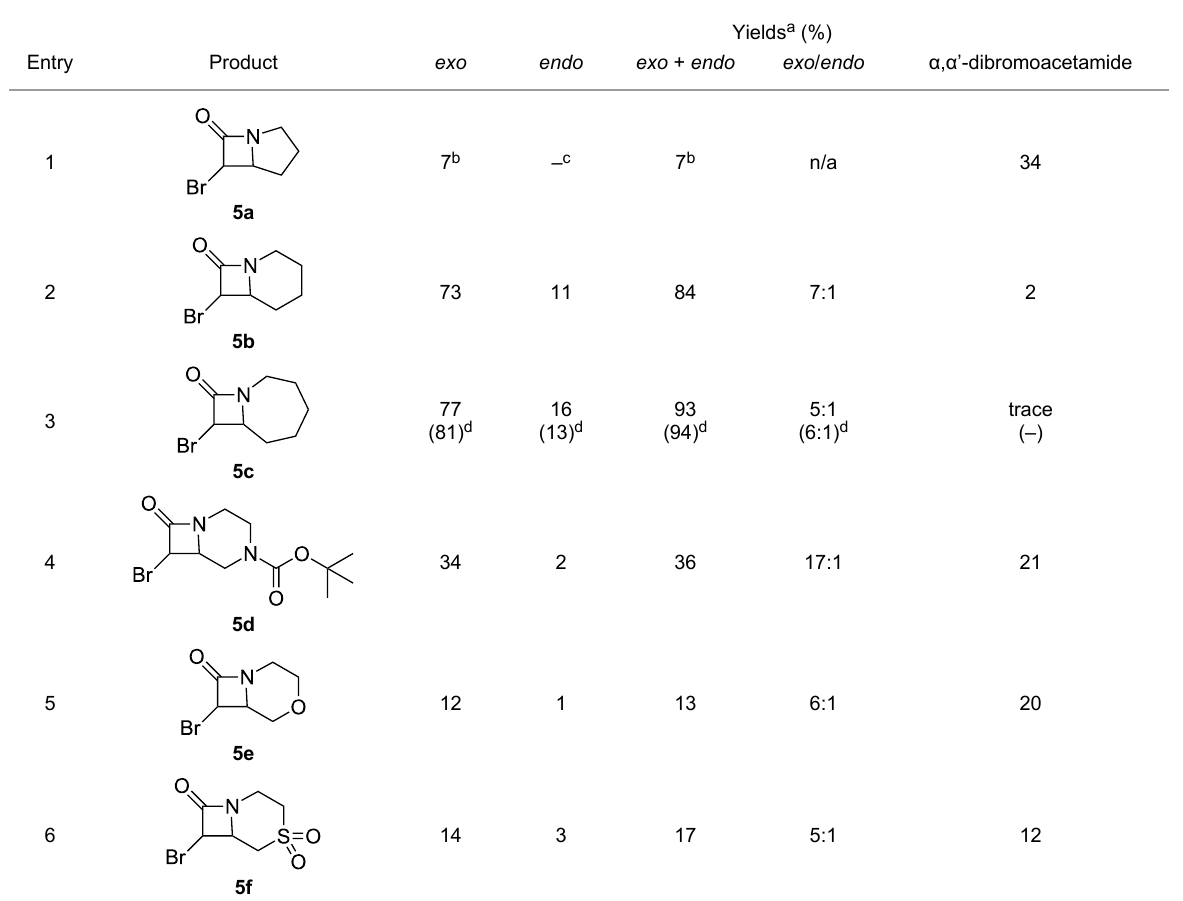
Table 1: Yields a of β -lactams 5a – f obtained by thermolysis of α -bromodiazoacetamides 4a – f .